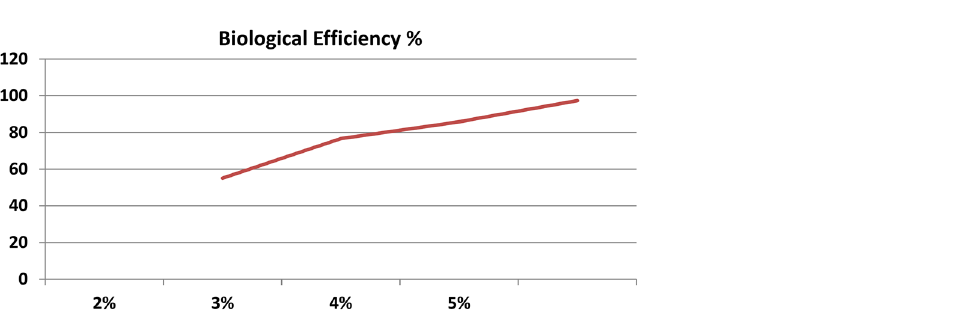
Figure 8. BE% obtained from different spawn